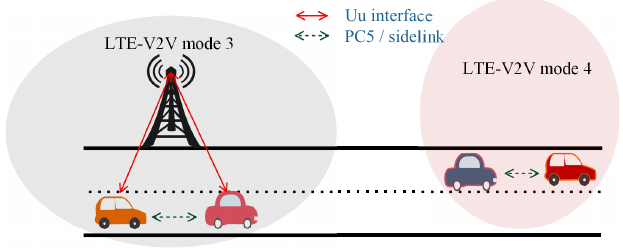
Figure 1. LTE-V2V Mode 3 and Mode